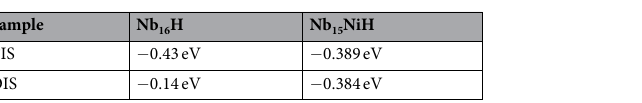
Table 1. Calculated solution energy ( E S ) of interstitial H atom in Nb 16 H and Nb 15